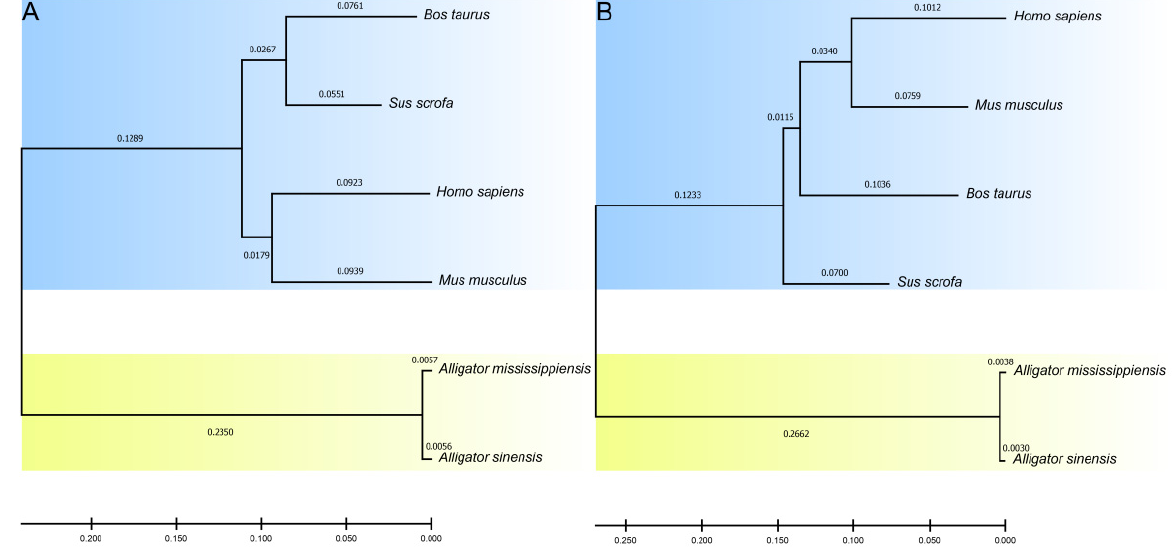
Figure 5. Phylogenetic relationships of C3d nucleotide sequences ( A ) and amino acid sequences ( B ) in two alligators and four mammals.